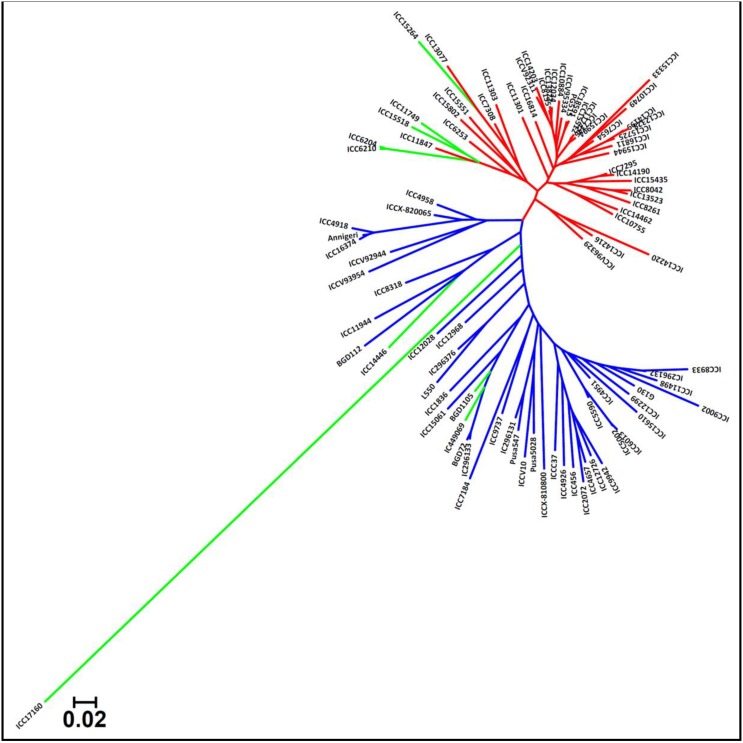
Unrooted phylogenetic tree depicting the genetic relationships among 93 cultivated and wild chickpea accessions based on Nei's genetic distance using 23,798 high-quality GBS-based SNPs (MAF ≥ 0.05). Molecular classification differentiated these accessions into two major clusters/population groups (kabuli and desi) as expected based on their cultivar/species-specific origination. The wild accession grouped distinctly within a POP III. Three different colors correspond to three populations (POP I, POP II, and POP III) as defined by population genetic structure.